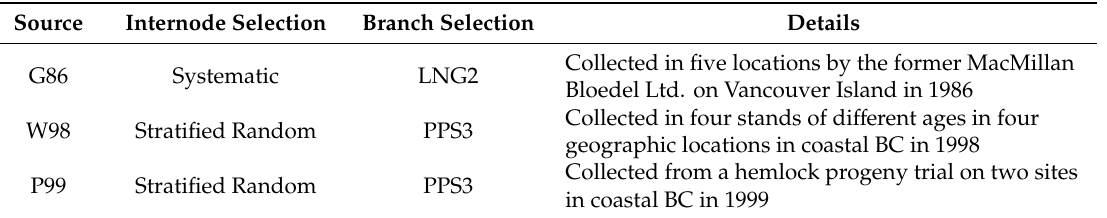
Table 2. Details on sources of data.